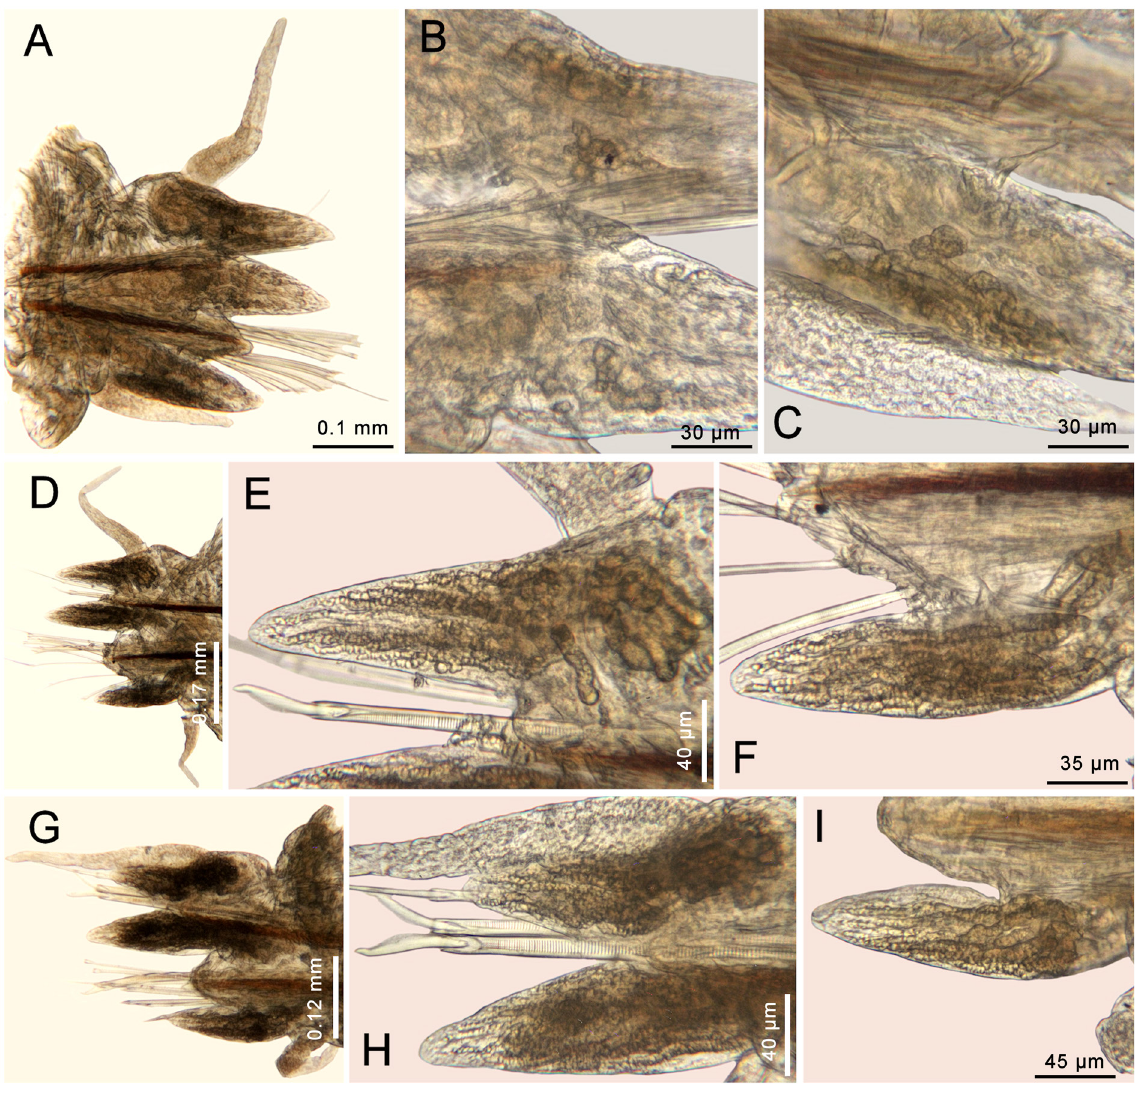
Fig. 2. Nereis mezianei sp. nov., non-type juvenile (MNHN 372-45). A . Chaetiger 9, left parapodium, anterior view. B . Same, base of notopodial ligules. C . Same, base of ventral ligule. D . Chaetiger 25, left parapodium, posterior view. E . Same, dorsal ligule. F . Same, ventral ligule. G . Chaetiger 46, left parapodium, posterior view. H . Same, notopodial ligules. I . Same, ventral